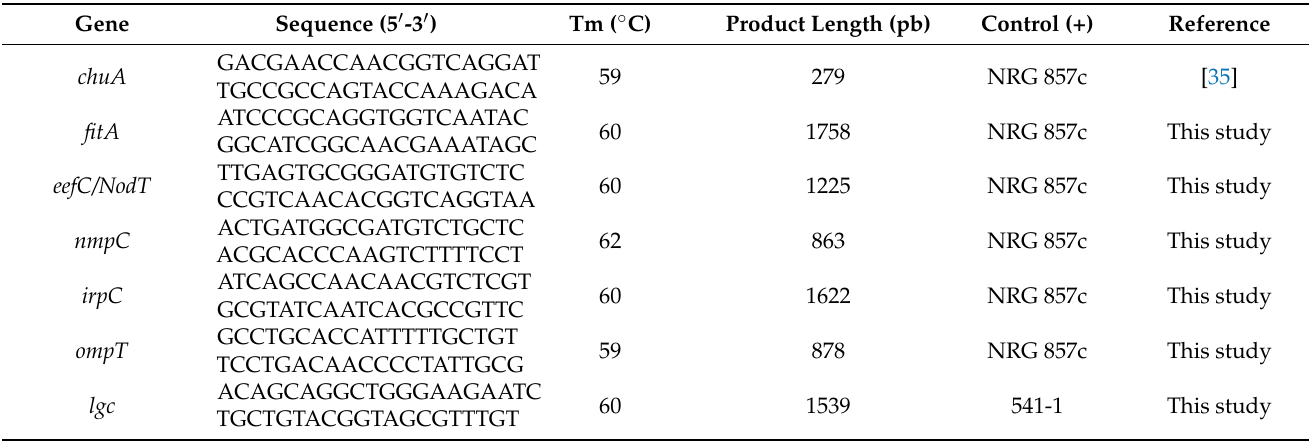
Table 1. Primer sequences used in this